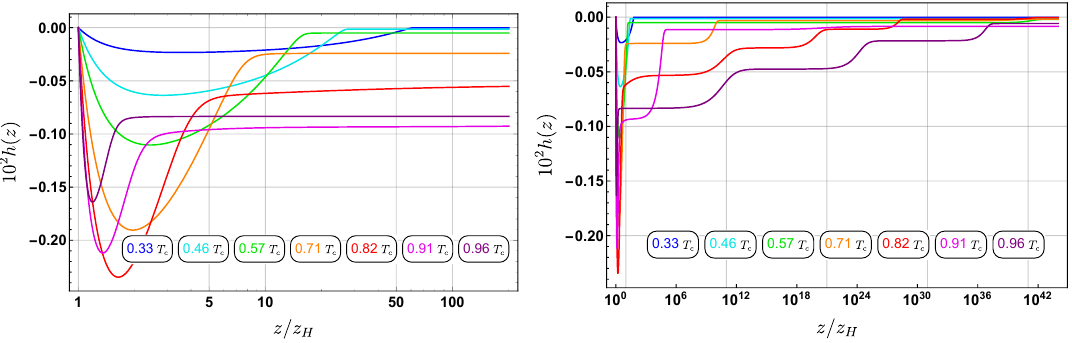
Figure 3 . The behaviors of h in function of z/z H inside the event horizon for the hairy black holes. There are strong non-linear effects at the near-horizon regimes below T alternations of different plateaus in the deep interior (right).